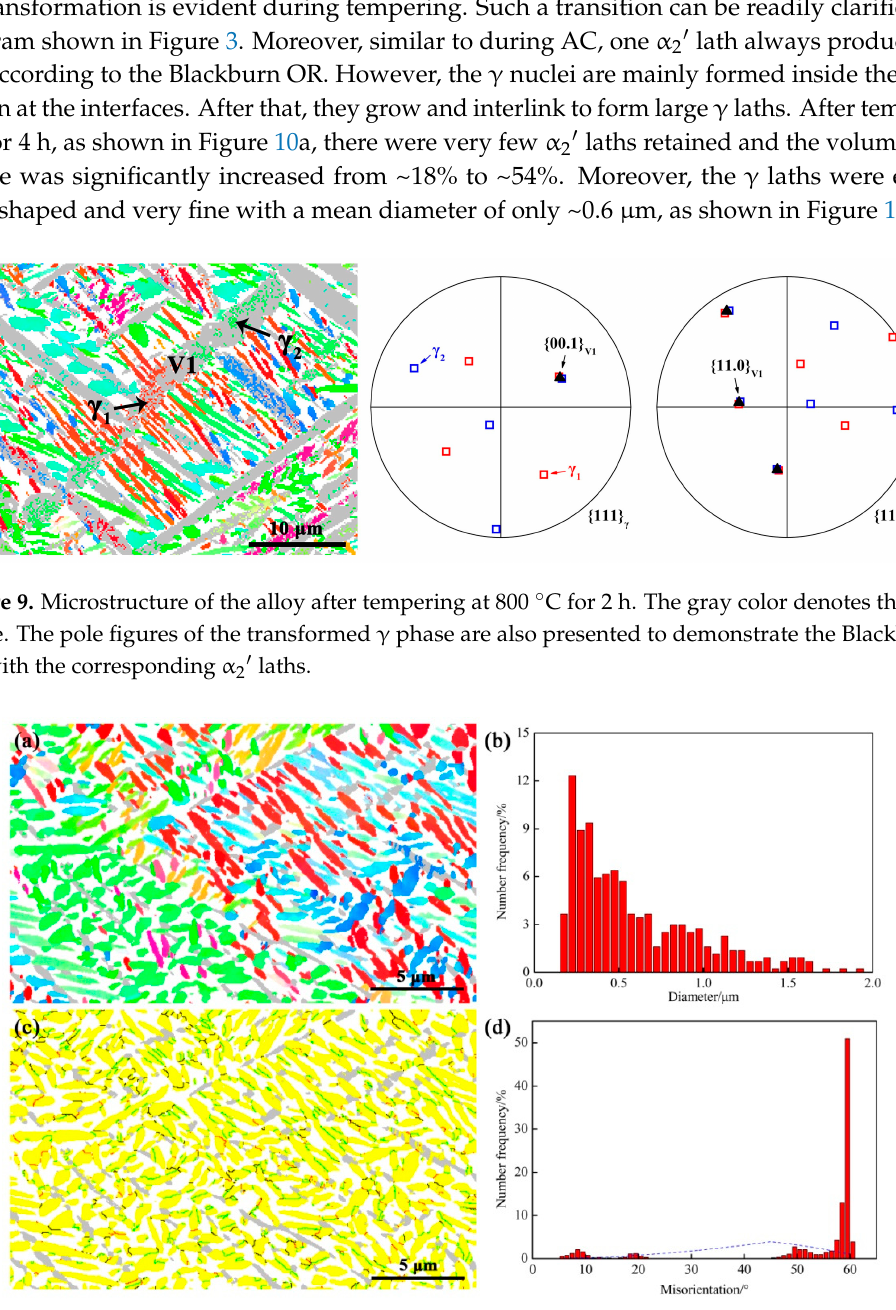
Figure 10. ( a ) Inverse pole figure map of the γ phase after tempering at 1000 °C for 4 h. The gray color denotes the retained α 2 ′ phase. ( b ) Histogram of the γ grain diameter distribution. ( c ) γ GB (grain boundary) map. The red lines denote the low-angle GBs with θ < 15° where θ is the misorientation angle, blue lines represent GBs with θ ≈ 60° and the black lines are normal high-angle GBs. ( d ) Histogram of the GBs misorientation distribution. The random distribution is represented by the dash line.